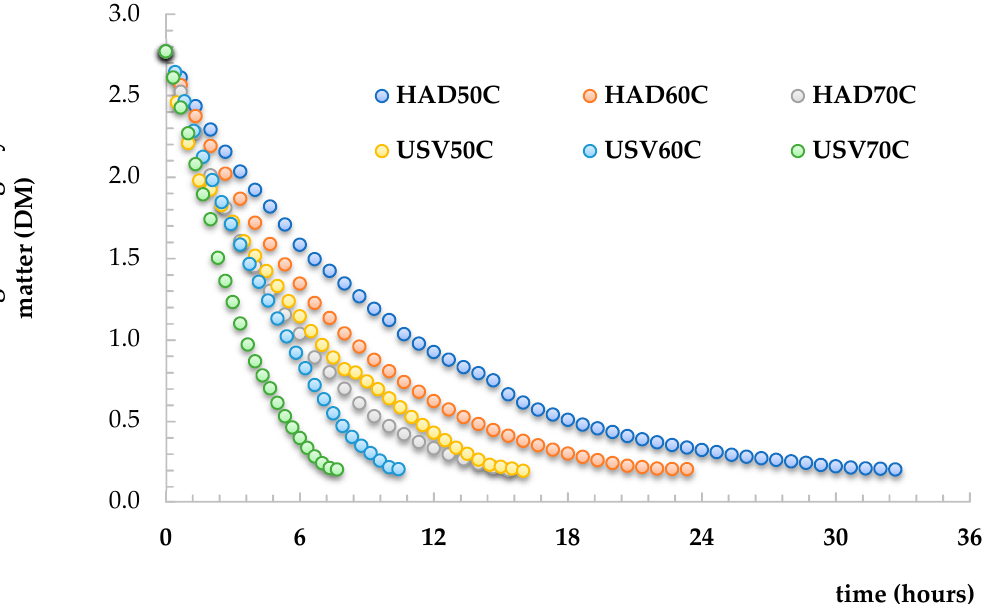
Figure 1. Drying kinetics of cherry laurel (HAD: hot air drying, USV: ultrasound-assisted vacuum drying).